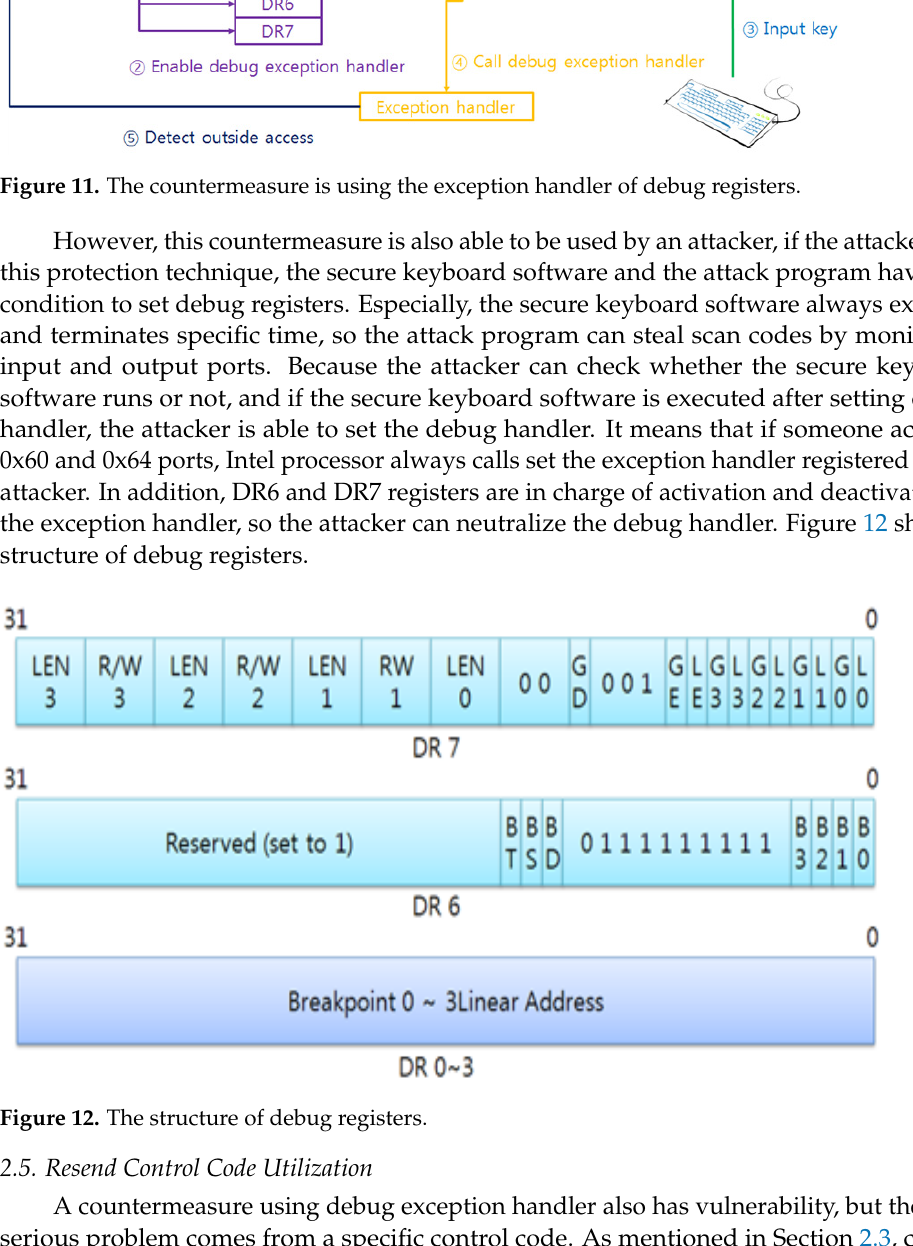
Figure 12. The structure of debug registers.